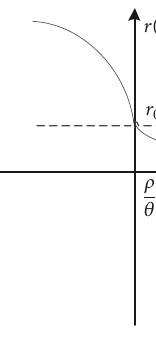
Figure 3: Curve of risk perception of the